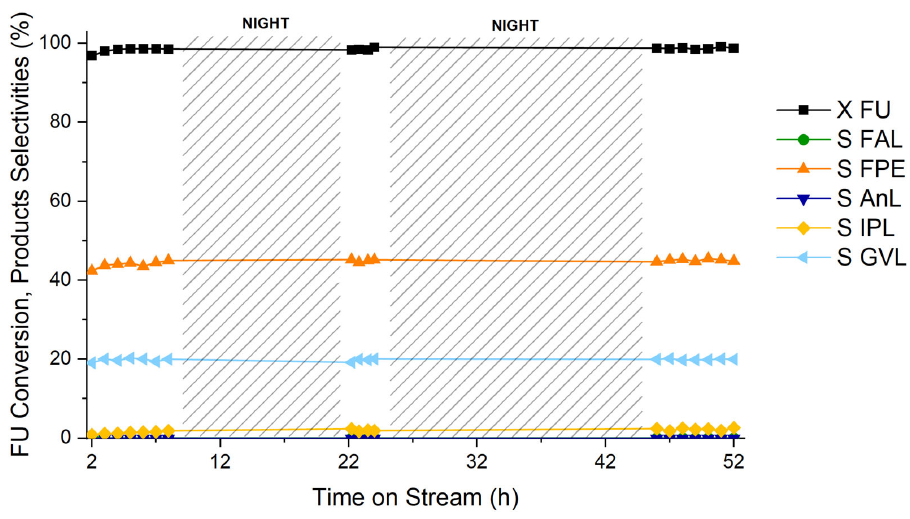
10 of 18 Figure 6. Undesired products formed from one ‐ pot reaction from FU to GVL. Figure 7 shows the catalytic performance of the Ti/Zr/O (1:1). The catalytic perfor ‐ mance was found to be stable. Characterization of the fresh and used catalyst based on XRD and surface area analysis confirms this stability as it showed the characteristic dif ‐ fraction peaks with a slight change in the intensity and a small decrease in surface area, therefore showing good structural stability (Figure S2). For the whole series of samples, surface area analysis showed a small to medium decrease in specific surface area, mean